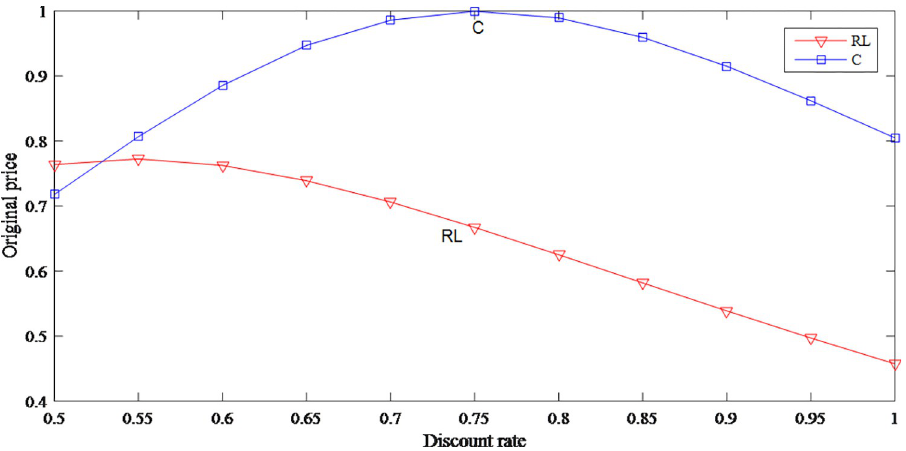
Fig 19. The impact of discount rate on original